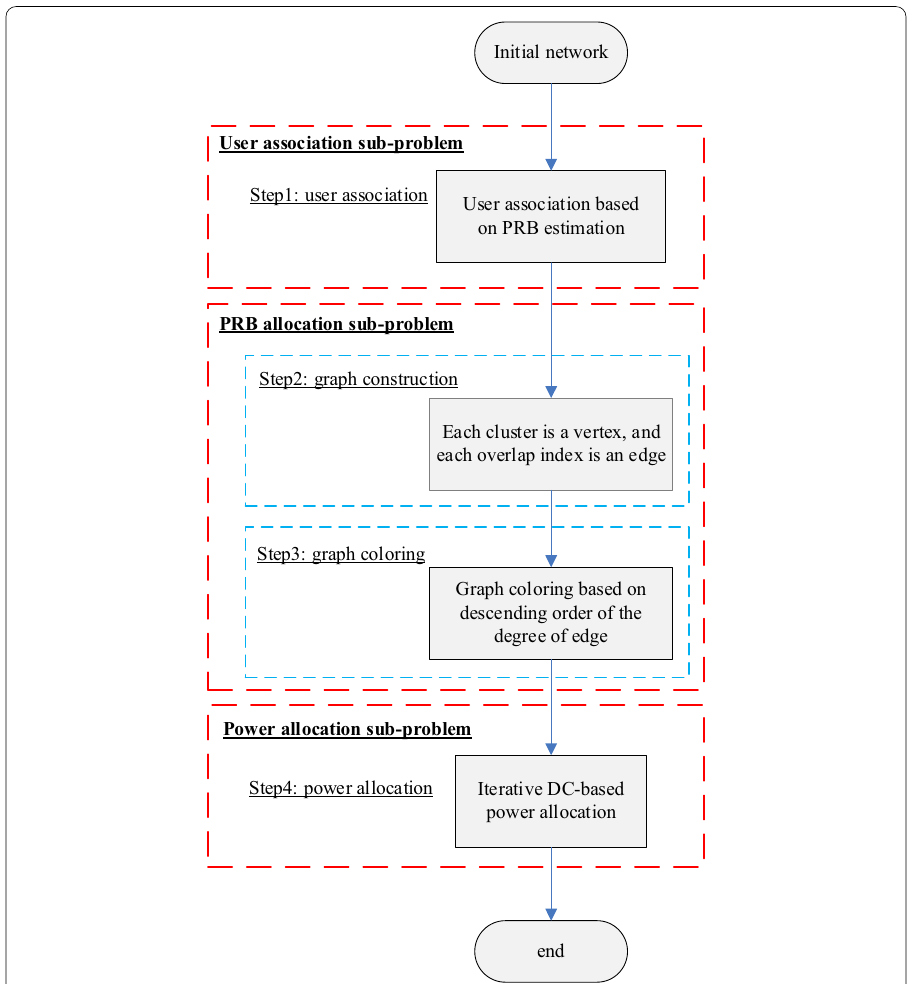
Fig. 2 Flowchart of the proposed user-centric overlapped clusters